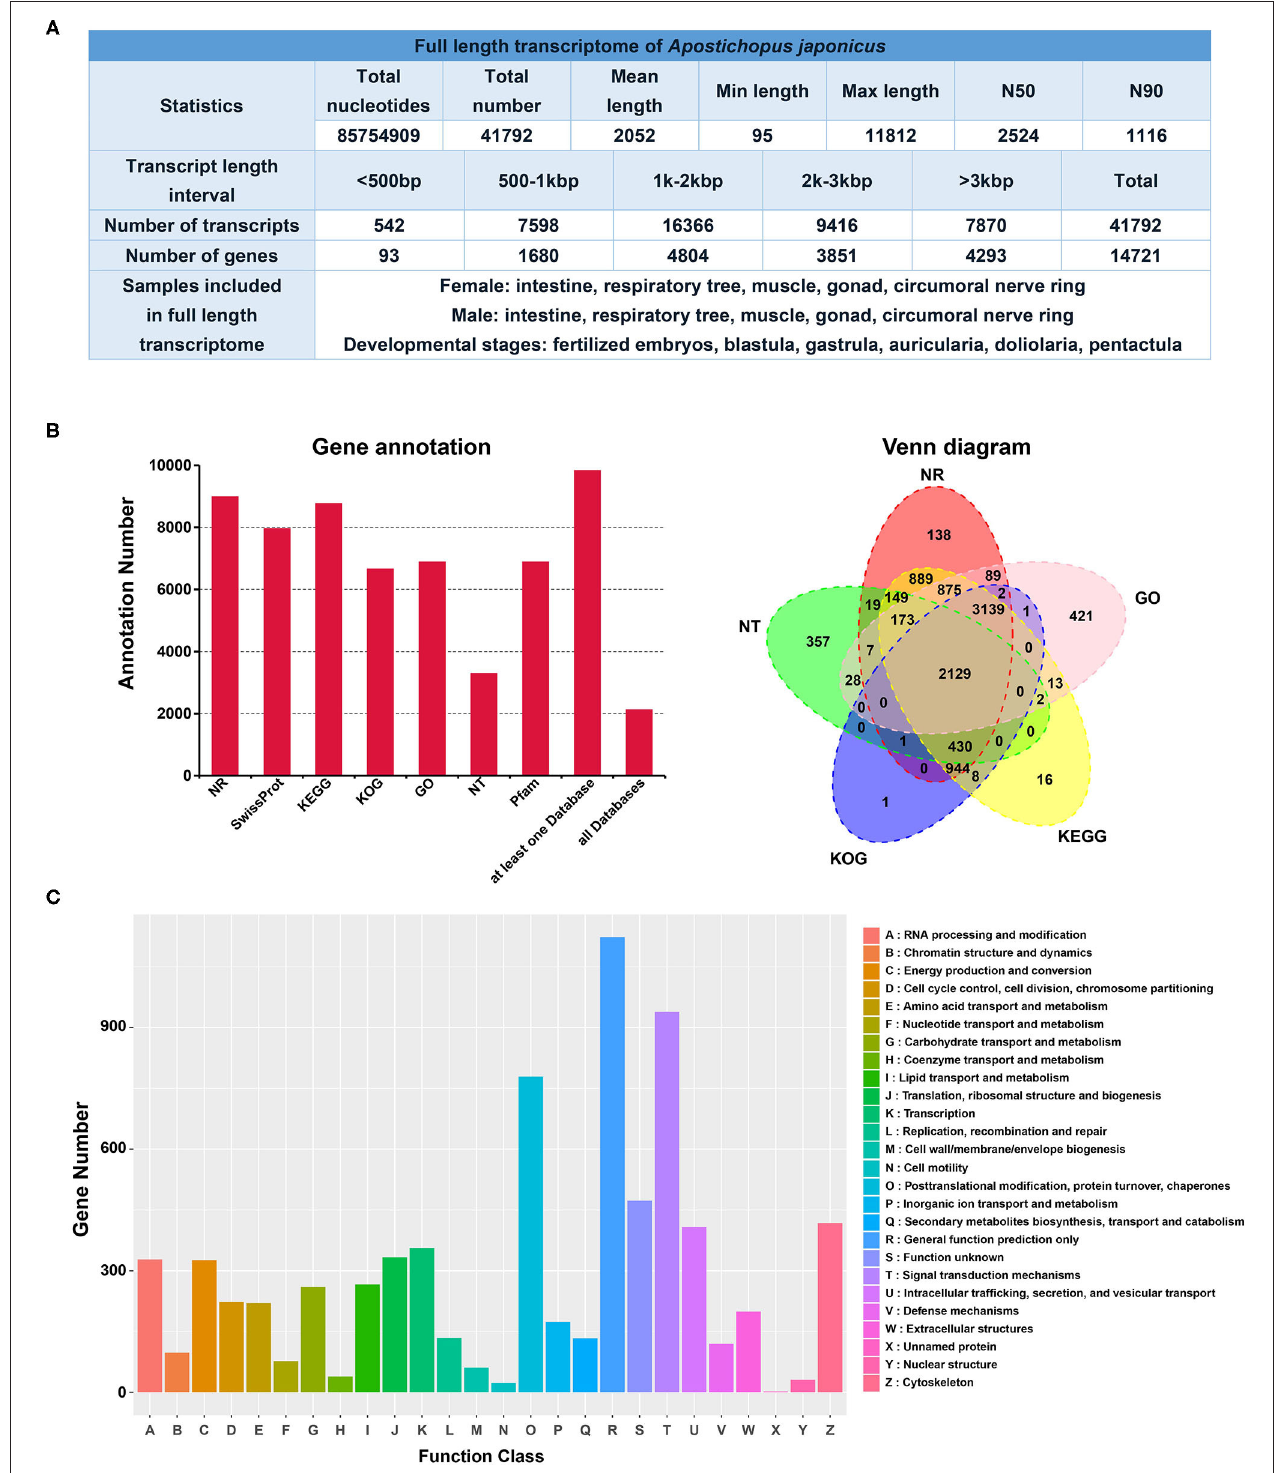
FIGURE 1 | (A) Statistics of Apostichopus japonicus full-length transcriptome; (B) Gene annotation and Venn diagram of A. japonicus full-length transcriptome; (C) Classification of annotated genes using KOG databases.